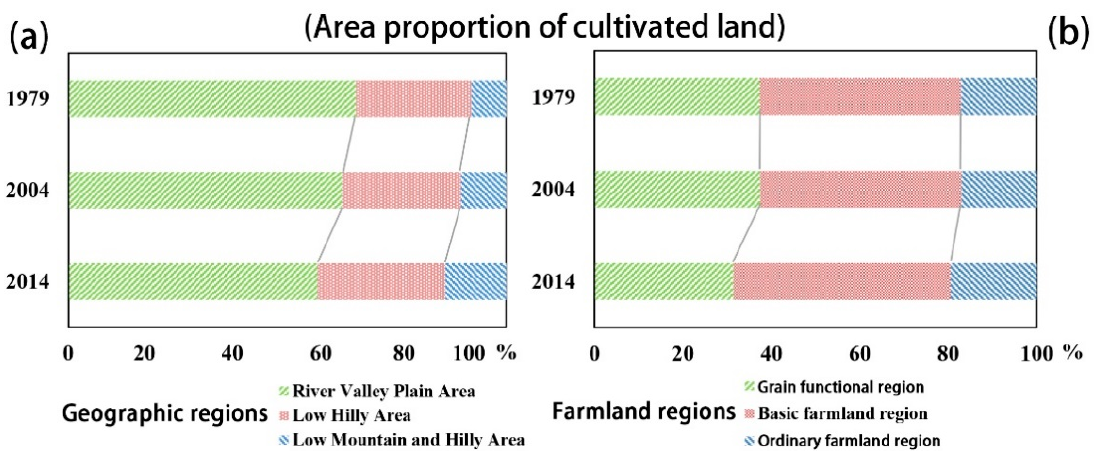
Figure 9. The crop planting structure in Fuyang District from the 1990s to the 2010s ( a ) and the content of nitrogen fertilizer consumption in Fuyang District from the 1980s to the 2010s ( b ).